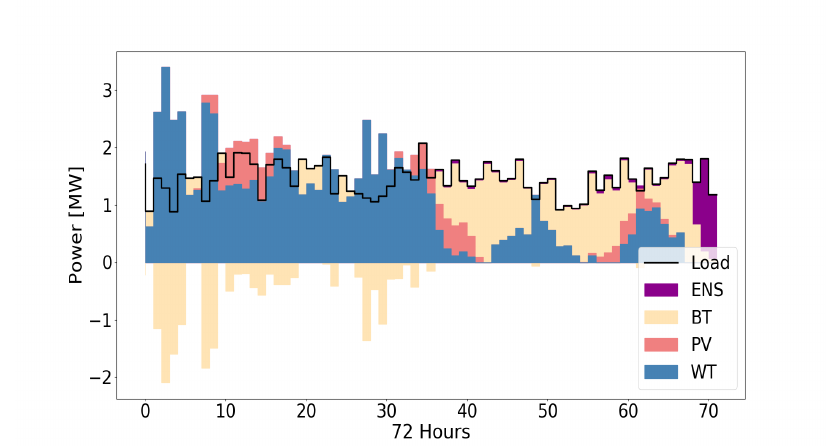
Figure 4. Scenario 4: electricity demand fulfillment